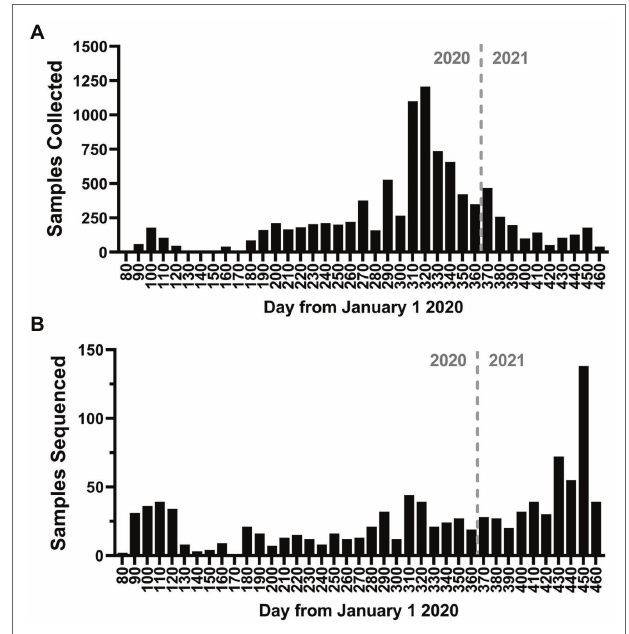
FIGURE 5 | Study sampling for genome sequencing. (A) Histogram of the number of positive nasal-pharyngeal severe acute respiratory syndrome coronavirus 2 (SARS-CoV-2) positive samples collected during the study period. (B) Histogram of the number of samples sequenced during the study period. The bin depth for both histograms is 10